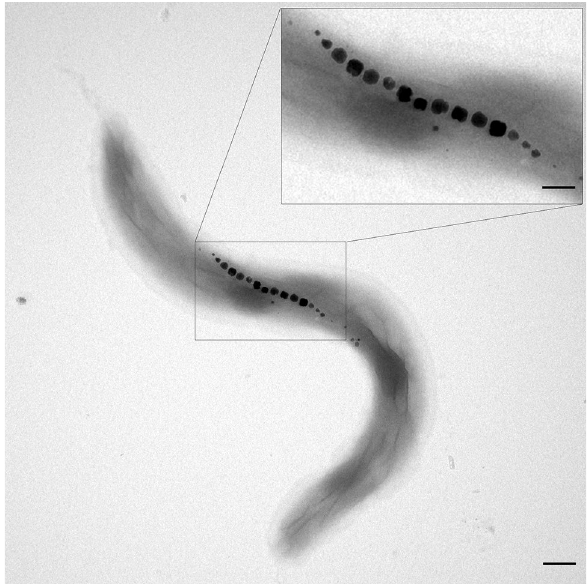
Figure 1. Transmission electron micrograph of Magnetospirillum magnetotacticum . In this typical cell, 15 magnetite crystals (electron dense particles) are arranged in a single-stranded magnetosome chain of ca. 500 nm length. Each crystal is surrounded by a membrane vesicle (not visible without membrane stain), which limits the crystal size to ca. 50 nm in this species and is responsible for the apparent gaps between the magnetosomes. Smaller magnetite crystals at the chain ends have not reached their final size and indicate the bidirectional growth of the chain. Scale bar 200 nm, inset scale bar 100